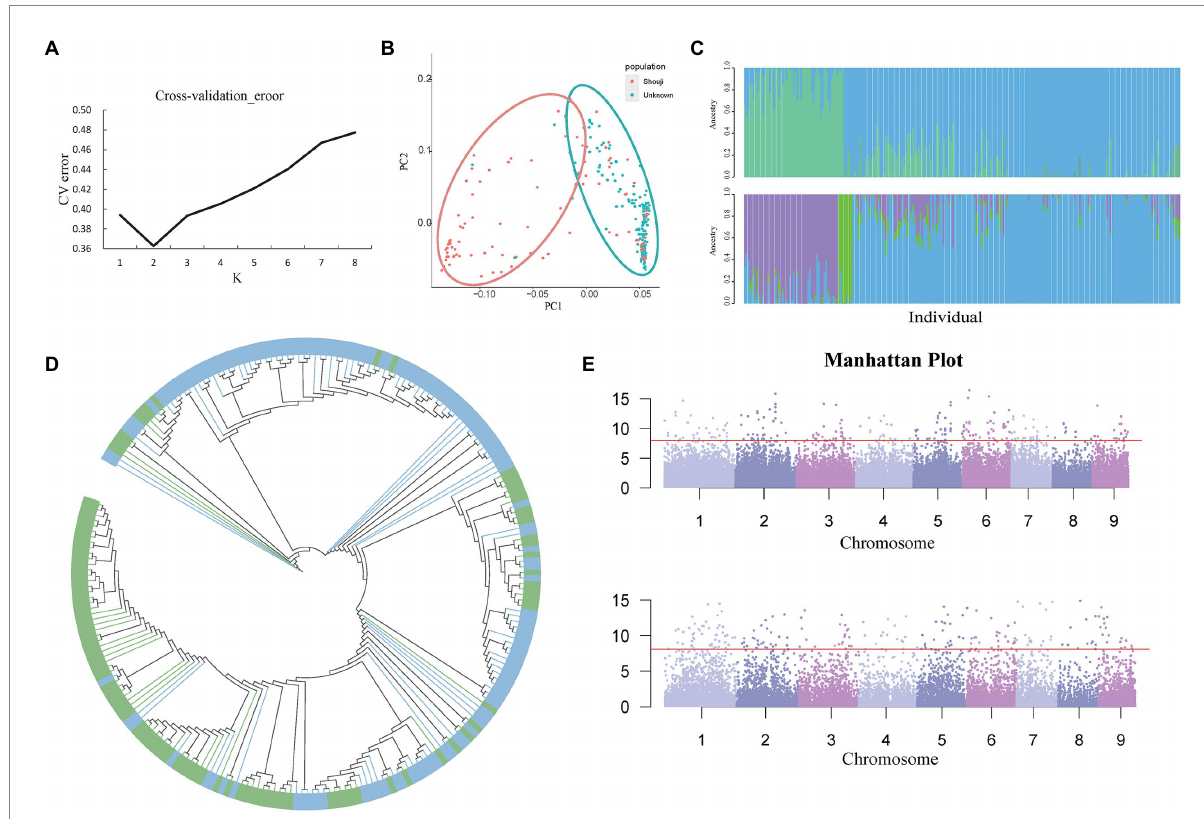
FIGURE 4 (A) Cv-error value under different K values. (B) PCA analysis based on 241 C. edulis samples. (C) The group structure of C. edulis when K = 2 or 3. Different colors represent different subgroups. (D) The neighbor-joining tree of the C. edulis population was constructed based on genetic distances; the blue color represents subgroup1, and the green color represents subgroup2. (E) Genome-wide association study (GWAS) analysis of two traits of leaf shape and color of C. edulis